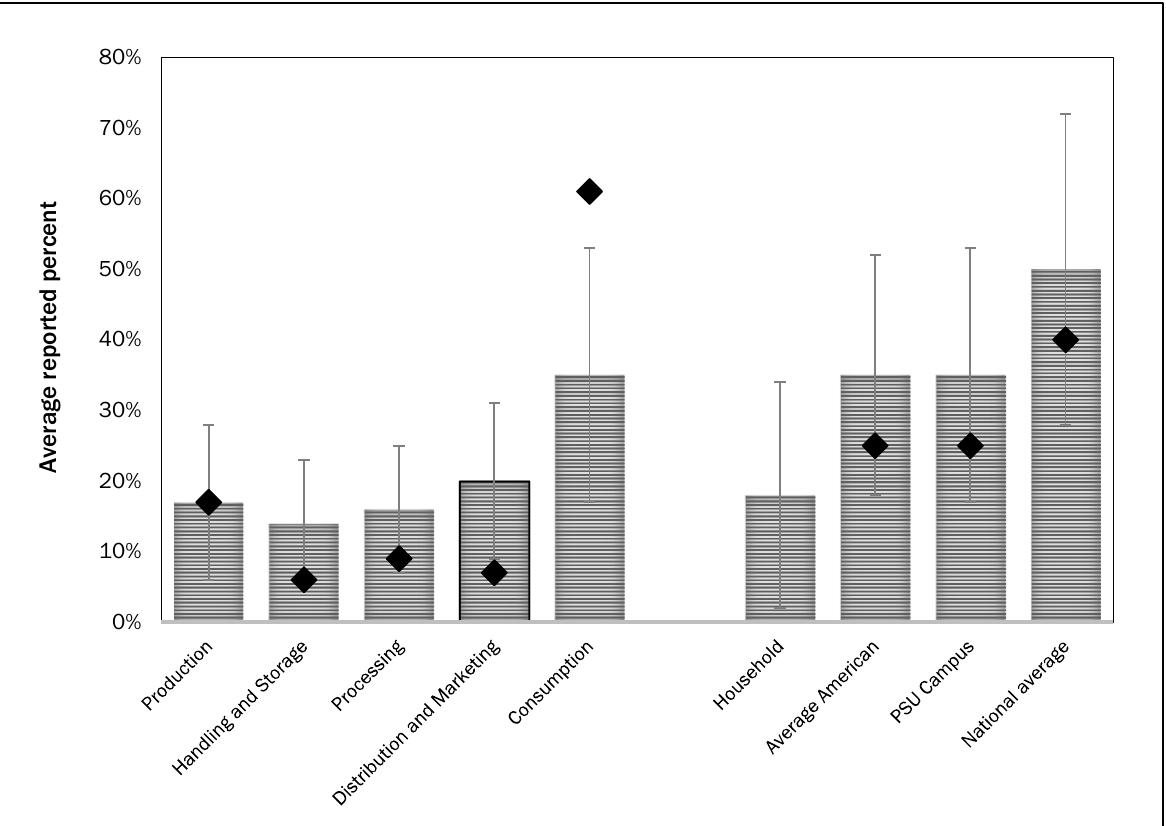
Figure 2. Average Perception of How Much Food Is Wasted Along the Food Cycle in the U.S. and at Vari- ous Consumer Levels Black diamonds ( ♦ ) represent the estimated “true” values of food waste for each level as reported in the literature (Doherty et al., 2013; Gunders, 2012a; Lipinski et al., 2013; Parfitt et al., 2010). Percent average household can be com- pared to the food waste of an average American, to its right, but no true value is given as the true value differs for each individual. Standard deviation of responses are represented with error